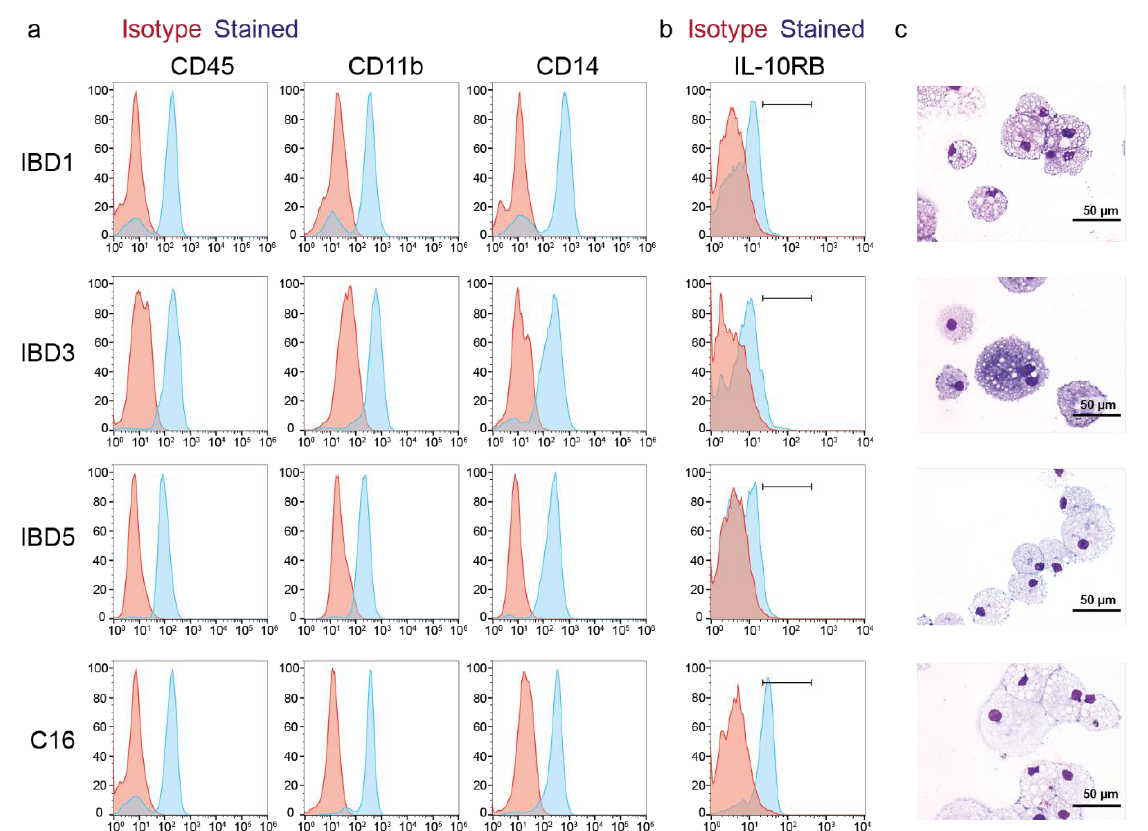
Figure 2. Macrophage differentiation of IL-10RB -/- VEO-IBD iPSCs. ( a ) Detection of macrophage surface marker expression (CD45, CD11b, CD14) on differentiated hematopoietic cells derived from healthy control (C16) and VEO-IBD (IBD1, IBD3, IBD5) iPSCs (red line, isotype; blue line, surface marker). ( b ) IL-10RB surface expression on iPSC-derived monocytes/macrophages analyzed by flow cytometry (red line, isotype; blue line, surface marker). ( c ) Morphological analyses by Pappenheim staining and light microscopy (bars correspond to 50 µm).